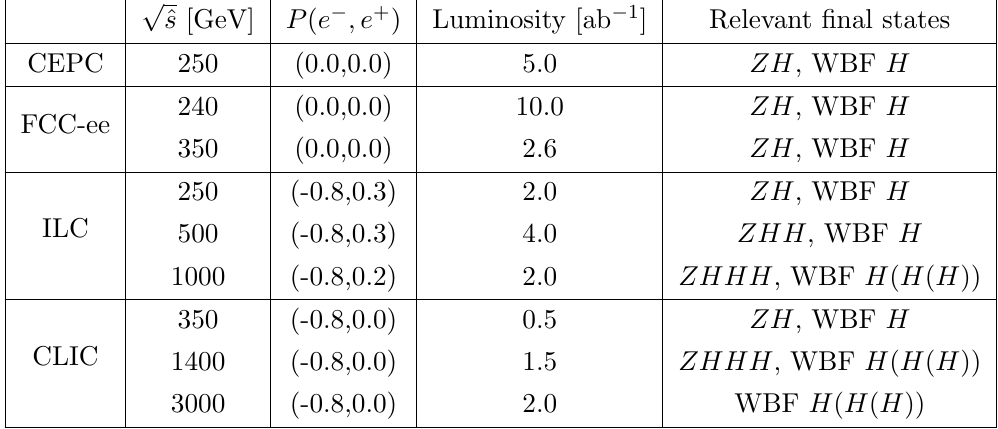
Figure 8 . LO cross section of ZHHH and WBF HHH as function of of (cid:22) c 6 and (cid:22) c 8 . The (cid:27) 02 component is also explicitly shown. Results refer to P ( e (cid:0) ; e + ) = ( (cid:0) 1 : 0 ; 1 : 0).